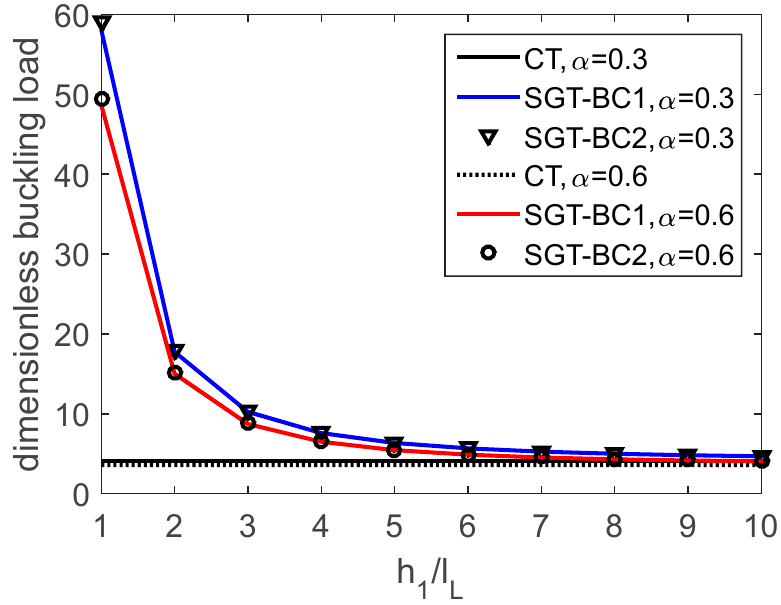
Figure 2. Variation of dimensionless buckling load for cantilever microbeams with respect to h 1 /l L for different taper ratios ( 𝑛 = 2 ).